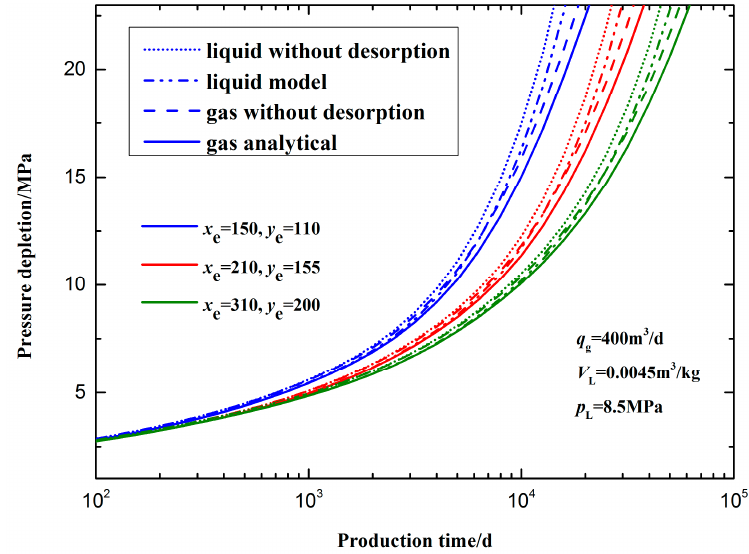
Figure 6. Effects of depletion-driven fluid properties, gas desorption, and outer boundary on